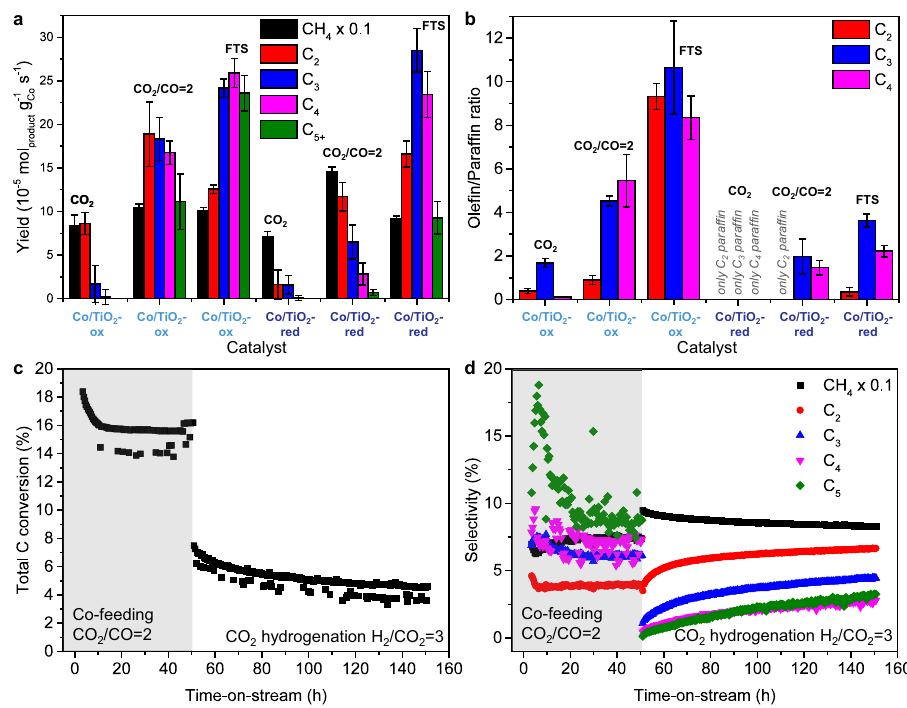
Fig. 6 Co-feeding CO/CO 2 to Co/TiO 2 to shift the selectivity to long-chain hydrocarbons and long-term stability. a Catalytic testing results ( T = 250 °C, P = 20 bar, GHSV = 3000 h − 1 , 10 h time-on-stream) comparing the product yields of CO 1) hydrogenation and Fischer – Tropsch synthesis (FTS; H 2 /CO = 2) for Co/TiO 2 containing CoO (suf fi x: -ox) or metallic Co (suf fi x: -red). b Ole fi n/Paraf fi n ratios for C 2 , C 3 , and C 4 products during CO 2 hydrogenation, CO/CO 2 (H 2 /CO 2 /CO = 9/2/1) hydrogenation, and FTS (H 2 /CO = 2). The whiskers in a and b indicate the standard deviation. Stability test ( T = 250 °C, P = 20 bar, GHSV = 3000 h − 1 ) of Co-TiO 2 -ox operated for 150 h displaying c conversion